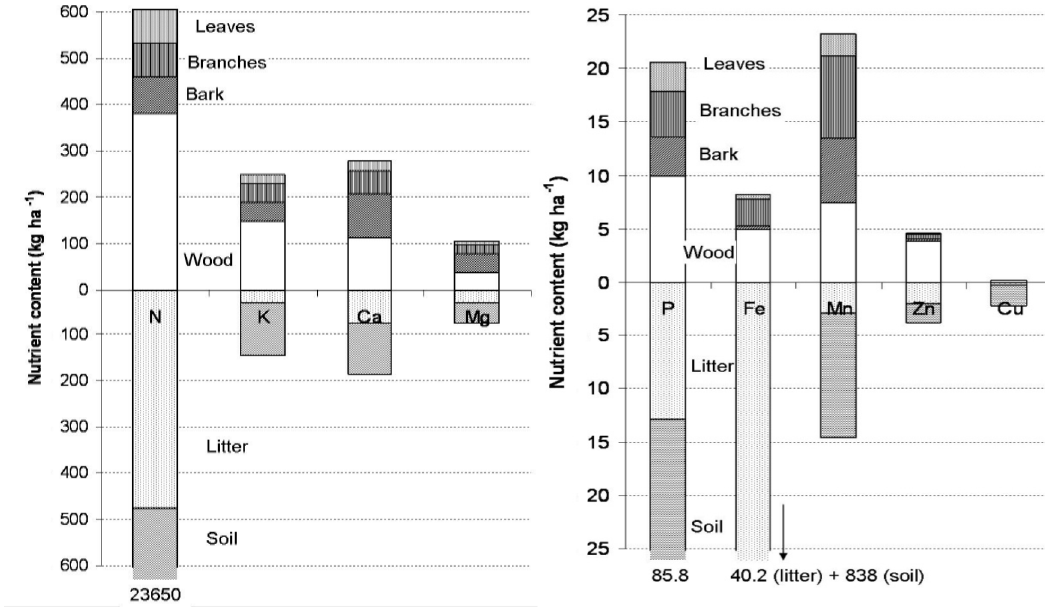
Figure 1. Biomass (Mg ha − 1 ) and nutrients (kg ha − 1 ) in the Eucalyptus globulus fractions and nutrients in the soil (kg ha − 1 ), in northwest Spain. Data are estimates for a rotation of 18 years [4]. Total N in soil and available for other nutrients.